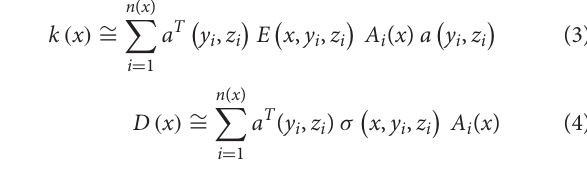
Frontiers in Built Environment |